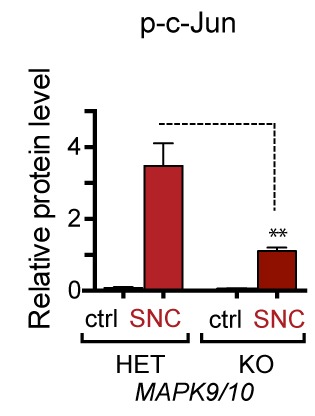
Quantification of p-c-Jun immunoblots presented in Figure 4a (JNK2/3-deficient L3/L4 DRGs 24 hr after SNC compared to HET controls, n = 3/condition).